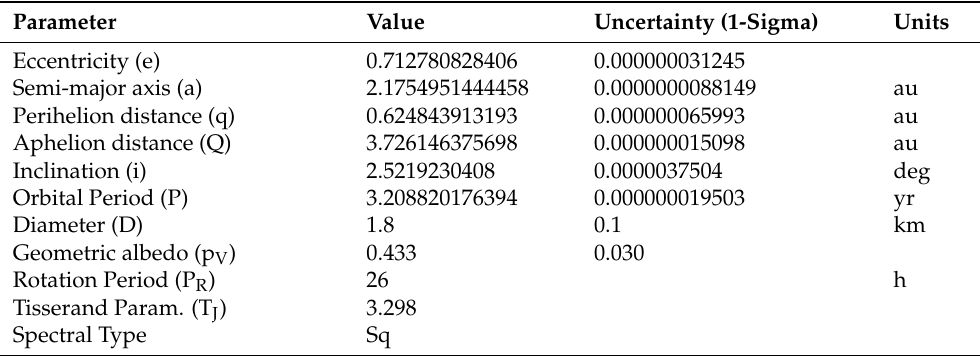
Table 4. Physical parameters of 2201 Oljato (1947 XC), classified as an Apollo asteroid , near-Earth object (NEO), and potentially hazardous asteroid (PHA). Data taken from the NASA/JPL Small-Body Database